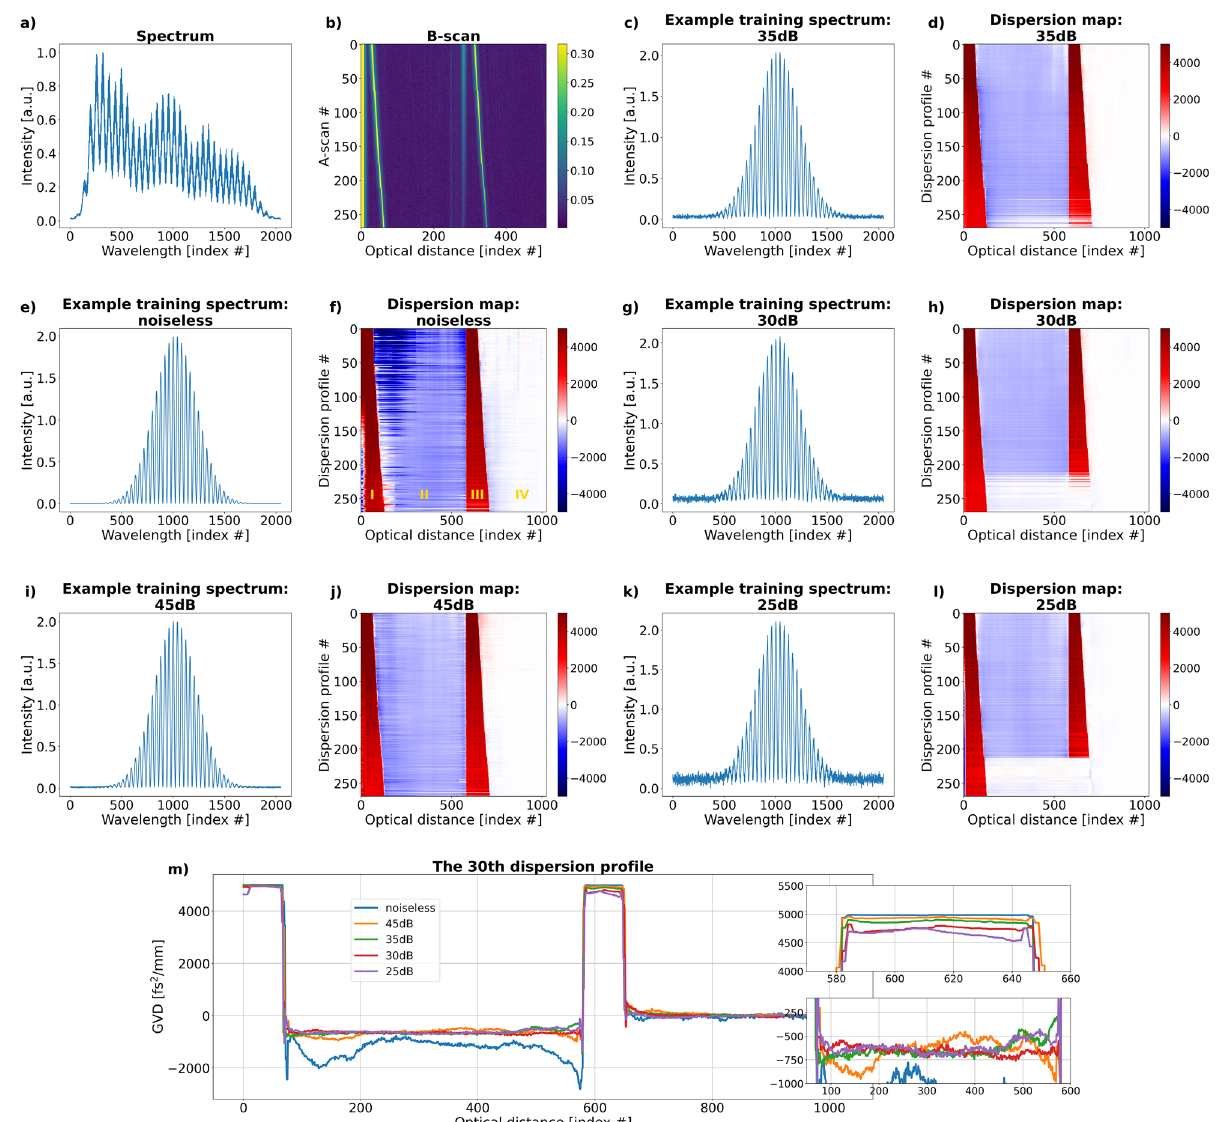
Figure 3. ( a ) One of the experimental spectra acquired for a 460-μm thick sapphire. ( b ) A B-scan showing a tilted sapphire glass. The vertical line represents autocorrelation peaks. ( f , j , d , h , l ) Dispersion maps of the sapphire glass obtained with a network trained with signals containing: no noise, 45, 35, 30 and 25 dB noise. All the dispersion maps are affected by the presence of the autocorrelation peaks: the network treats them as structural peaks and assigns GVD levels to them. I–IV mark four areas that can be discerned as a result. ( c , e , g , i , k ) Example training spectra showing what the simulated noise levels look like. ( m ) The 30th dispersion profile from all five predicted dispersion